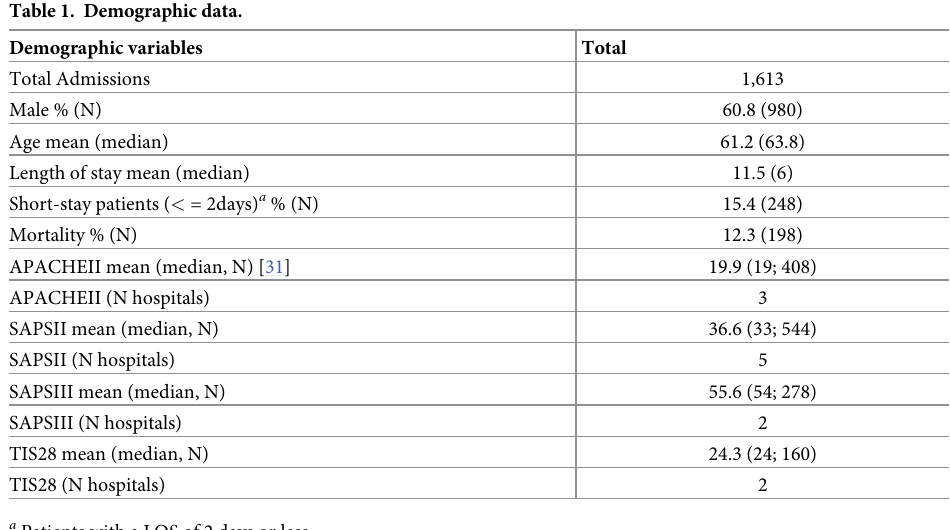
Table 1. Demographic data. Demographic variables Total